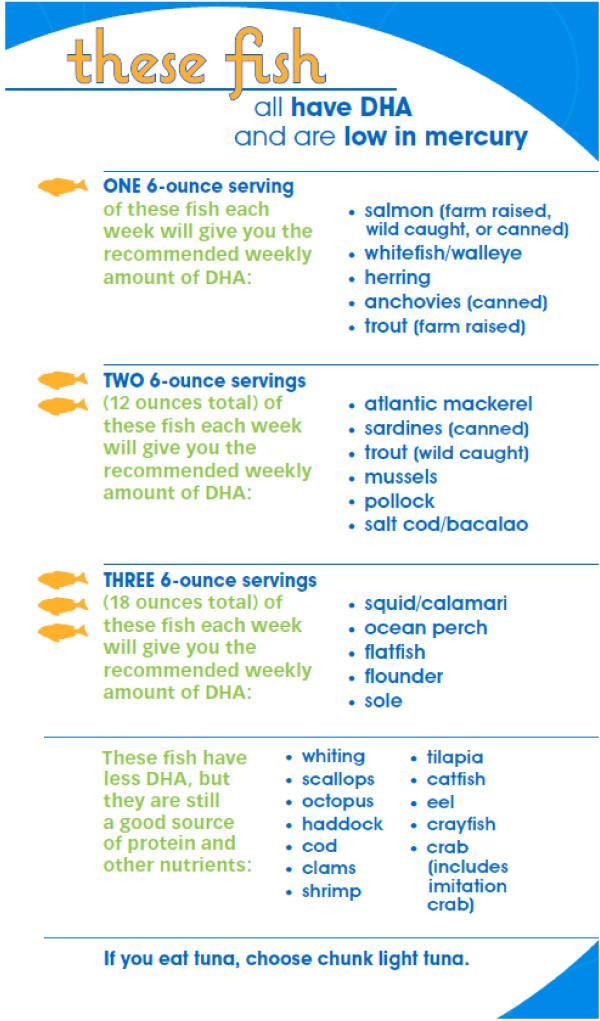
List of fish types provided to participants in the Advice and Advice+Gift Card arms.